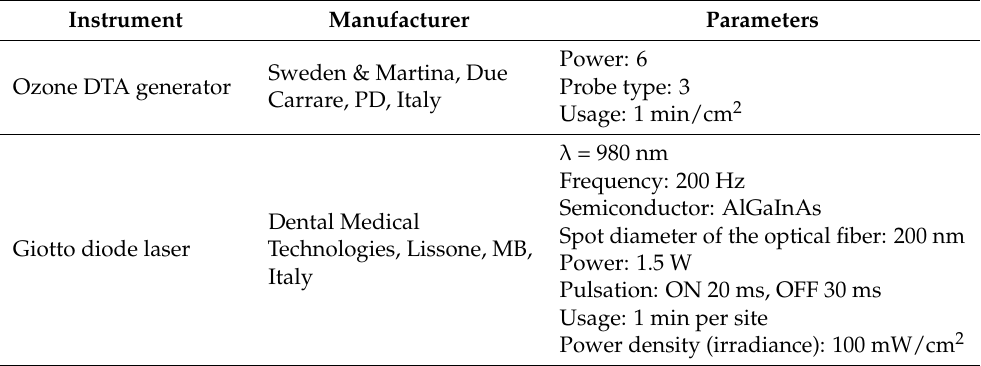
Figure 1. Treatments administered to patients from group A ( left figure) and from group B ( right figure). Table 1. Working parameters of the two treatments.